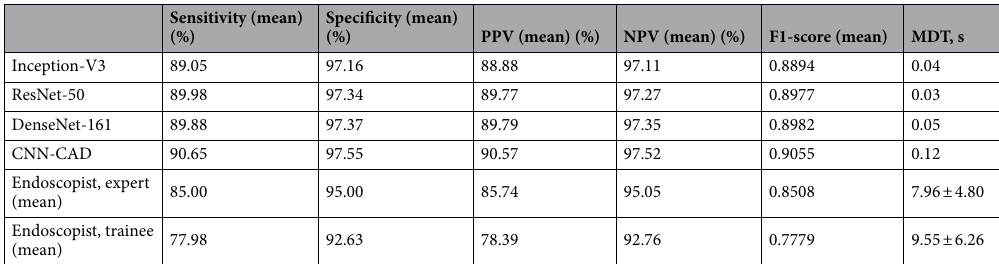
Table 2. Cross-validation results with performance comparison among the evaluated deep learning algorithms and endoscopists. NPV negative predictive value, MDT mean diagnostic time per image, PPV positive predictive value, s